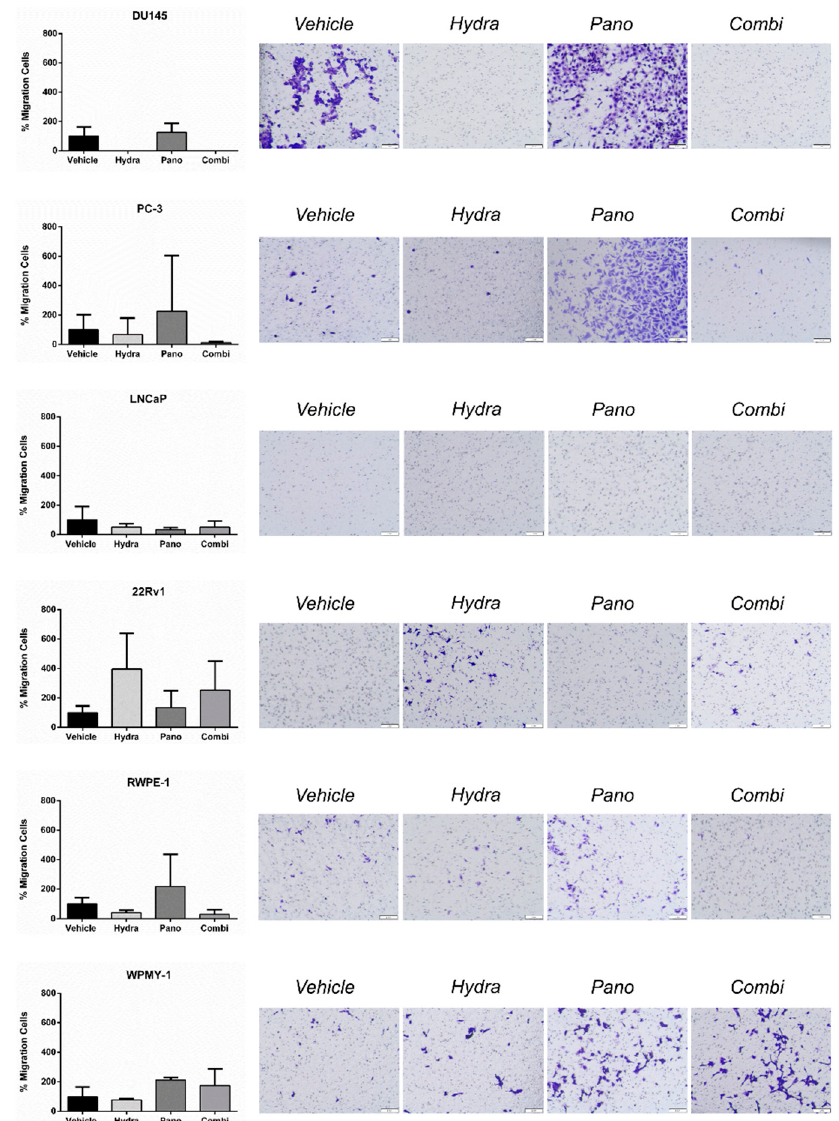
Figure 7. Effects of hydralazine and panobinostat exposure in prostate cell lines migration potential. Cell lines were seeded in migration invasion transwell inserts upon epidrug exposure for 24 h. The percentage of invasive and migratory cells was determined by dividing the mean counted cells by the area of the microscope viewing field and then multiplying by the entire area of the insert. The results are representative of three biological replicates ( n = 3). Mean values ± SD are shown (left panel). Representative images of invasive and migratory cells stained with Crystal Violet are displayed (right panel). The inserts were photographed with stereomicroscope Olympus S2X16 using a digital camera Olympus SC180 (scale bar 1 mm) at 115 × magnification. Drug concentrations: DU145–Hydra: 50 µ M, Pano: 5 nM; PC-3, RWPE-1 and WPMY-1–Hydra: 100 µ M, Pano: 10 nM; LNCaP–Hydra: 100 µ M, Pano: 5 nM; 22Rv1–Hydra: 75 µ M, Pano: 1